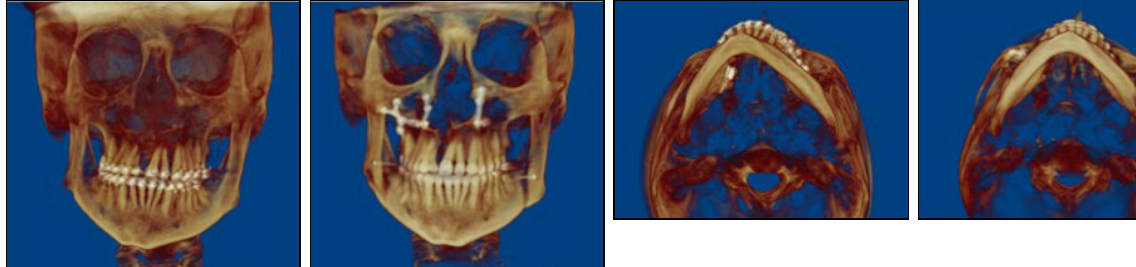
Figure 6. Pre-surgical and post-surgical three-dimensional images.